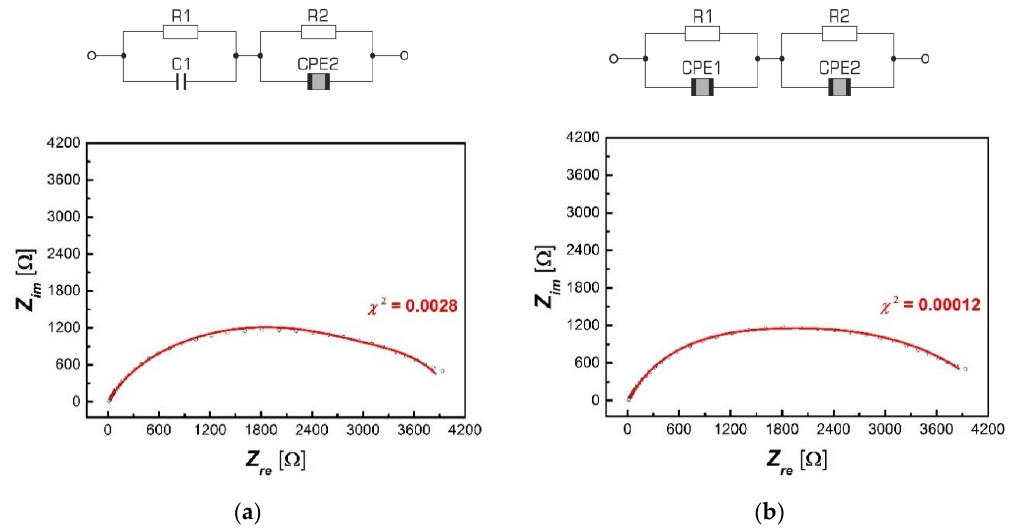
Figure 10. Graphs of the dependence of the imaginary part of impedance ( Z im ) on its real part ( Z re ) together with the matching spectrum for selected electric replacement models obtained at T = 455 °C; for a system with a single CPE ( a ) and for a system with a double CPE ( b ). The characteristics of Z im ( Z re ) take the form of deformed, at times asymmetrical, single semi- circles, and their shape allows us to conclude that the obtained relationships are the result of the imposition of two semi-circles representing the electrical response of grains and grain boundaries.